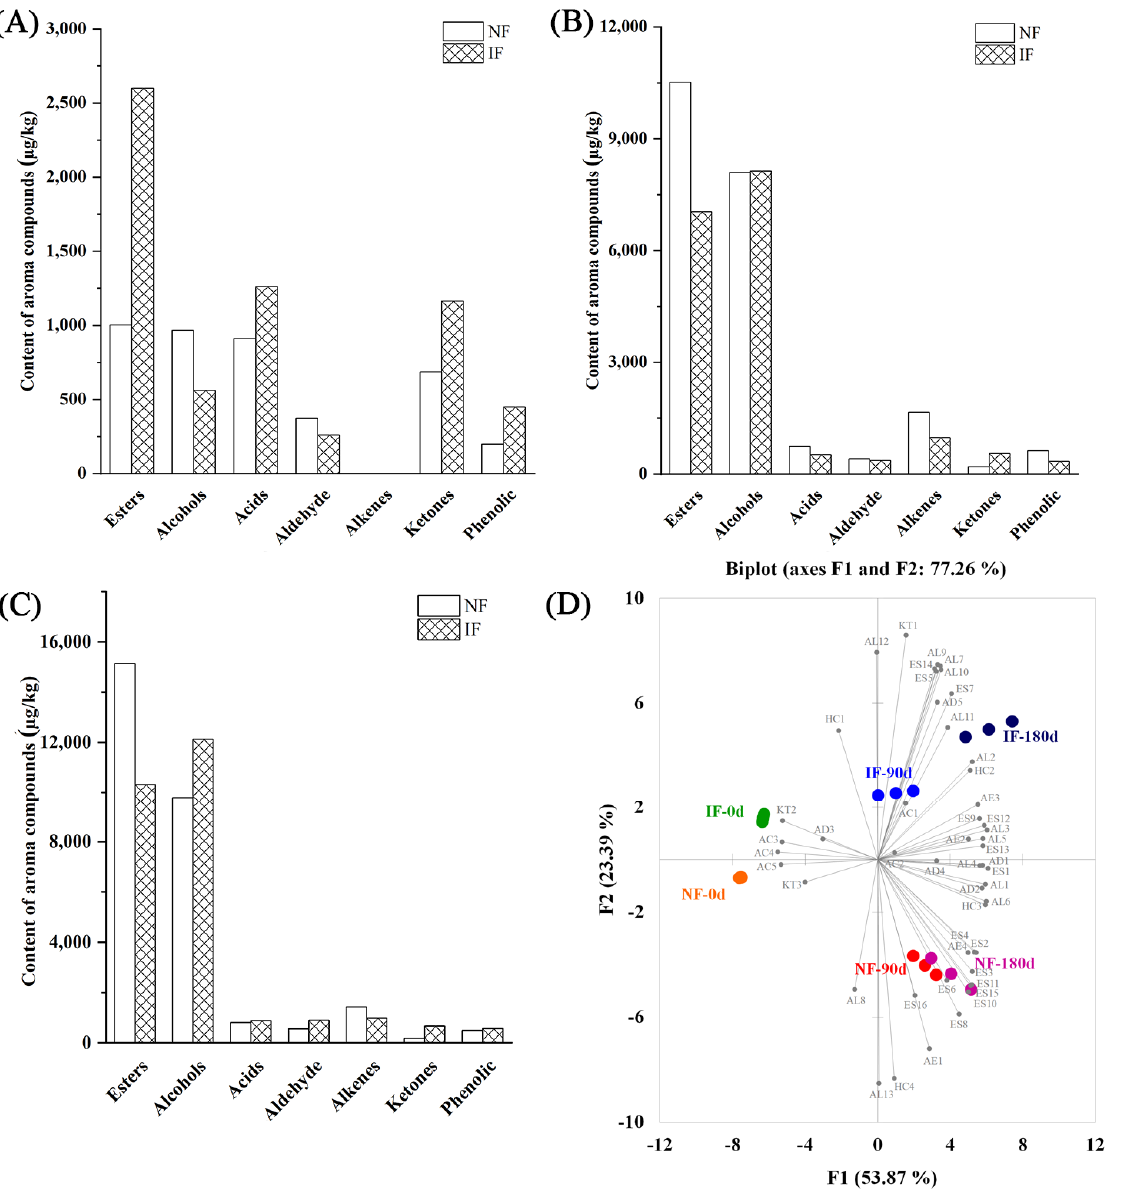
Figure 4. Comparison of aroma compounds between natural and inoculated fermented sufu at 0 d ( A ), 90 d ( B ) and 180 d ( C ) of fermentation and PCA analysis ( D ). NF: natural fermentation; IF: inoculated fermentation. Note: ES1: ethyl octanoate; ES2: ethyl palmitate; ES3: ethyl linoleate; ES4: ethyl acetate; ES5: 5 − 2 − phenylethyl propionate; ES6: 14,17 − octadecyl methyl dienoate; ES7: ethyl